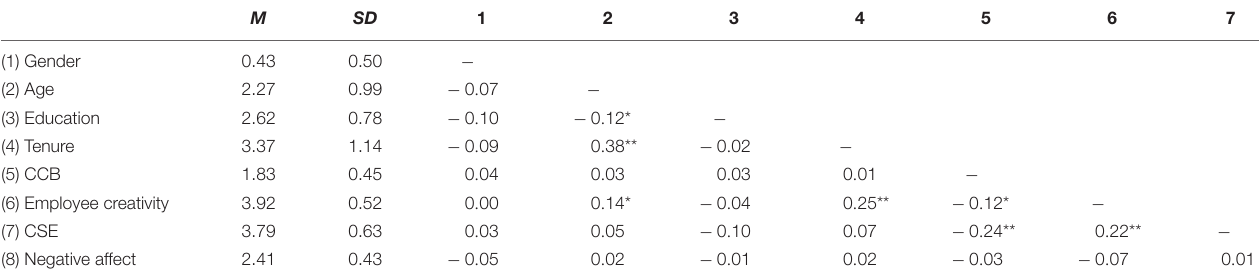
TABLE 2 | Means, standard deviations, and intercorrelations of study variables ( N = 251).